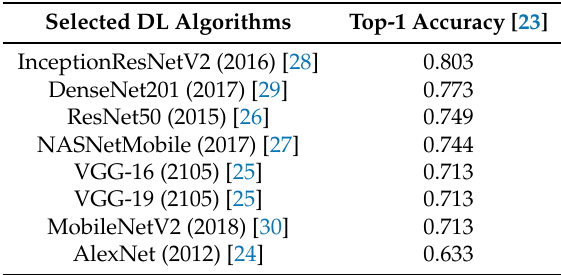
Table 5. List of DL algorithms used in this work for PNe True versus Rejected and for the morphological